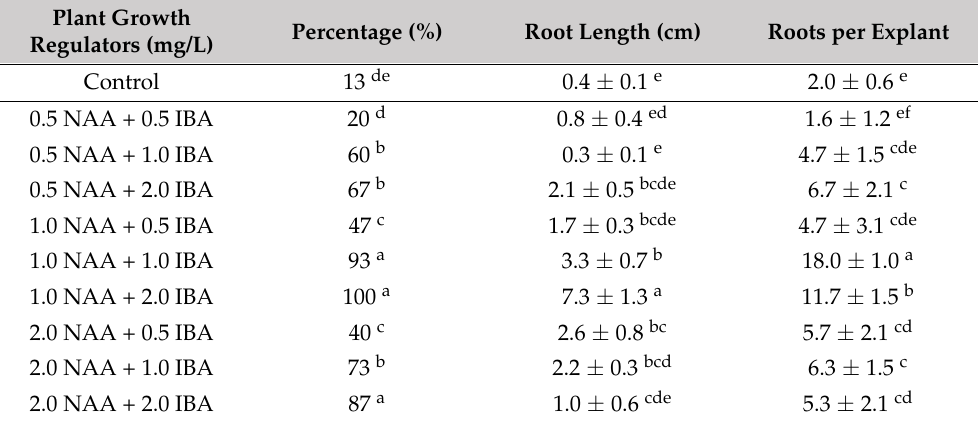
Table 1. Initiation of adventitious roots of Z. zerumbet in MS medium supplemented with different combinations and concentrations of plant growth